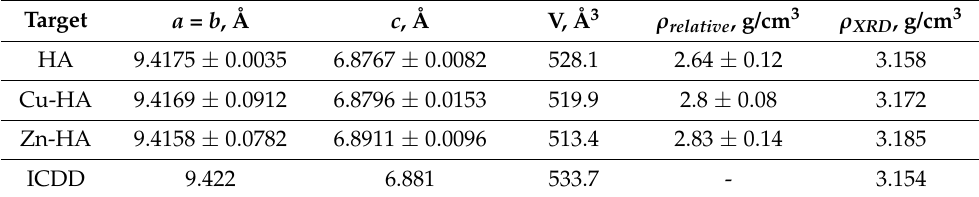
Table 2. Results of X-ray diffraction analysis and density measurements of HA, Cu-HA, and Zn-HA targets.